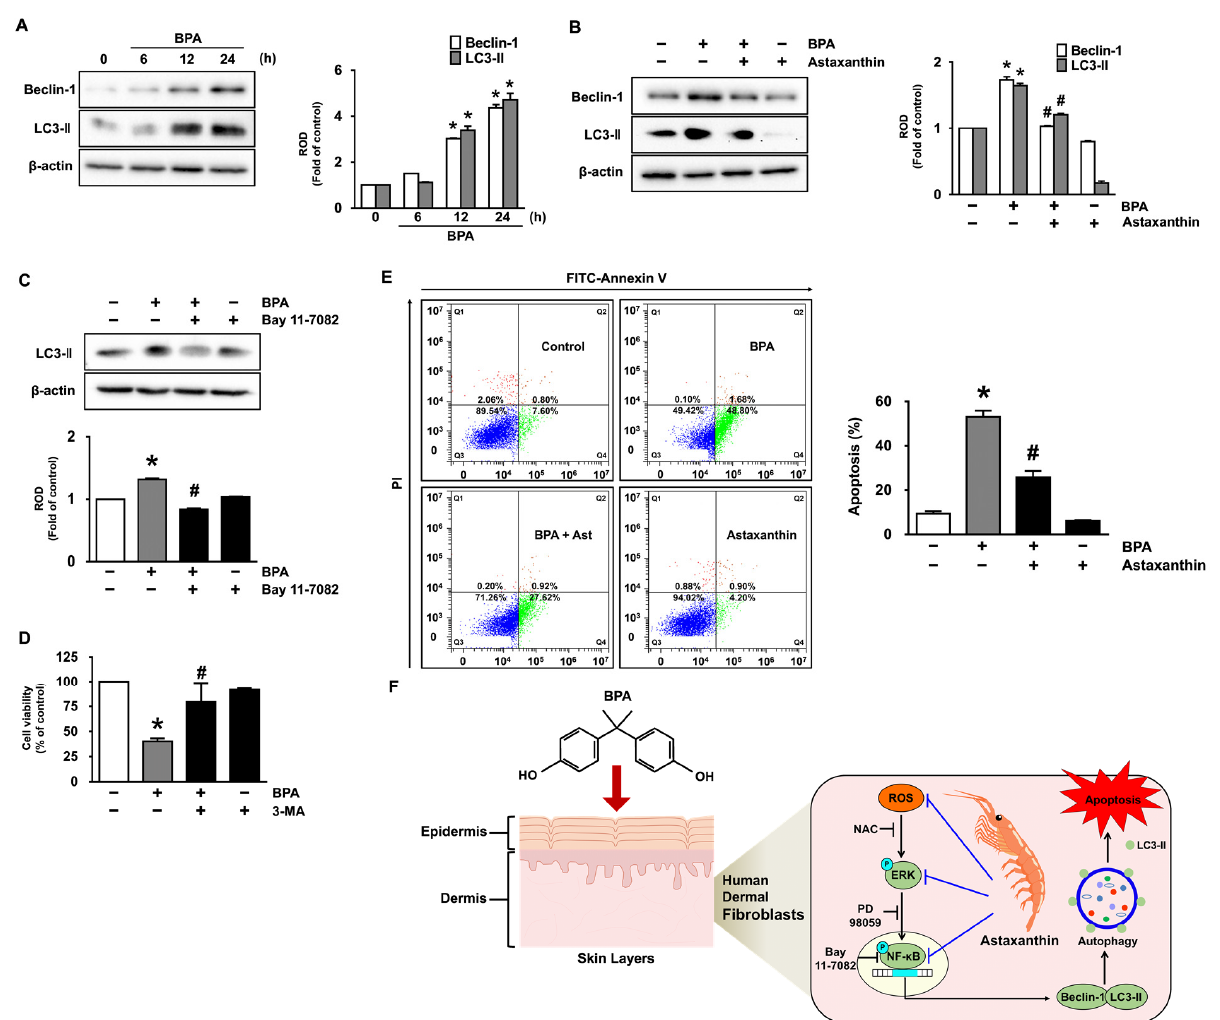
Figure 5. Astaxanthin regulates the autophagic cell death triggered by BPA ( A ) Time responses of BPA (50 μ M) on the protein expression of Beclin-1 and LC3-II are shown. * p ≤ 0.001 versus 0 h. n = 3. ROD, relative optical density. ( B ) The role of astaxanthin in the expression of autophagy-related proteins is shown. * p ≤ 0.005 versus control, # p ≤ 0.001 versus BPA alone. n = 3. ( C ) Cells were incubated with 1 μ M of Bay 11-7082 for 30 min prior to BPA exposure for 24 h. * p ≤ 0.001 versus control. # p ≤ 0.001 versus BPA alone. n = 3. ( D ) Cells were incubated with 1 μ M of autophagy inhibitor (3-MA) for 30 min prior to BPA exposure for 24 h. The effect of 3-MA on the levels of cell viability is shown. * p ≤ 0.001 versus control. # p ≤ 0.01 versus BPA alone. n = 3. ( E ) The proportion of apoptotic cells stained by Annexin V was analyzed by performing flow cytometry. * p ≤ 0.05 versus control. # p ≤ 0.05 versus BPA alone. n = 3. ( F ) The sequences of putative signaling pathways are summarized.